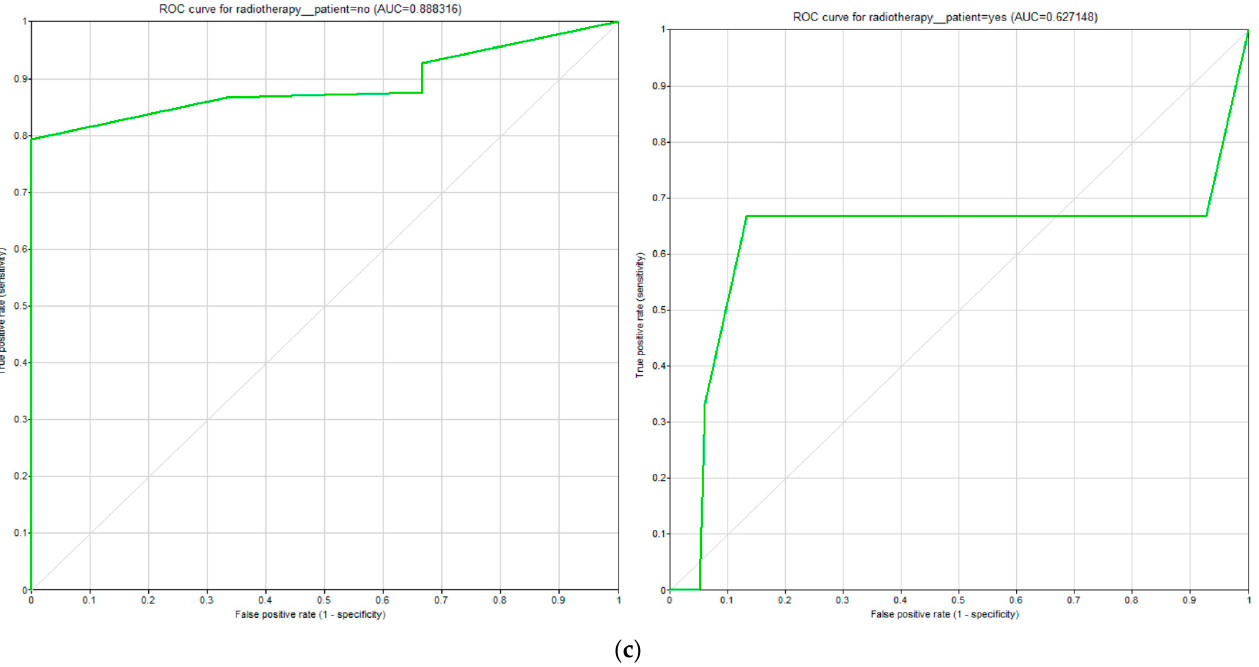
Figure 5. ( a ) ROC curves for treatment option “surgery”, ( b ) ROC curves for treatment option “radiochemotherapy”, ( c ) ROC curves for treatment option “radiotherapy”. Table 4. F 1 measure for larynx model.